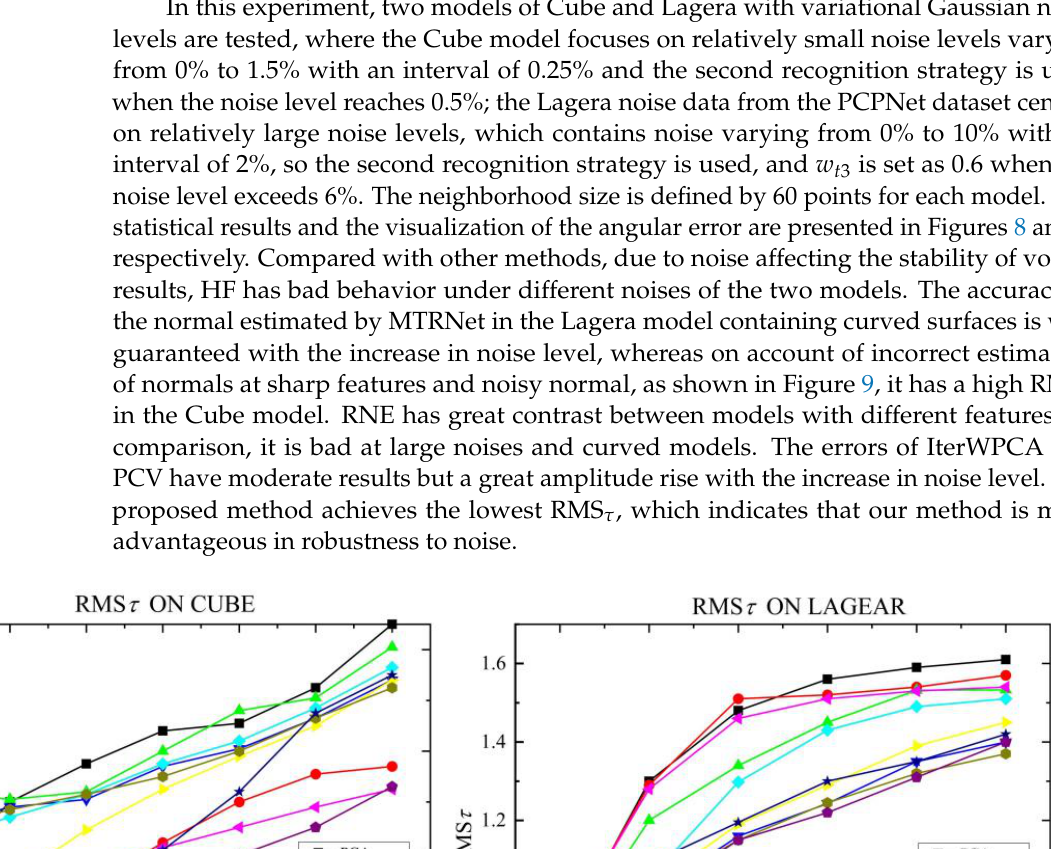
Figure 9. Visualization of angular error evaluated in Cube and Lagera models in the experiment of robustness to noise. 6.2. Qualitative Evaluation We further demonstrate the performance of our method in point cloud filtering ap- plications. In the experiment phase, we utilize an effective point updating algorithm [1,43], a point cloud smoothing algorithm Bilateral method [44], and EGT [45], in which the nor- mal information used in this algorithm is matched by the estimated normal output via each method. To obtain better results in the experiment, we alternately call the normal